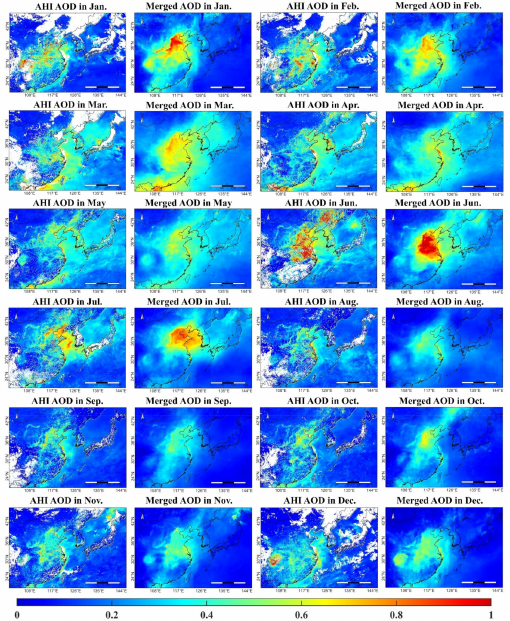
Figure 9. Maps of the monthly spatial distribution in 2017 for the original Himawari-8 L2 AHI and merged AOD datasets. The color bar represents the AOD